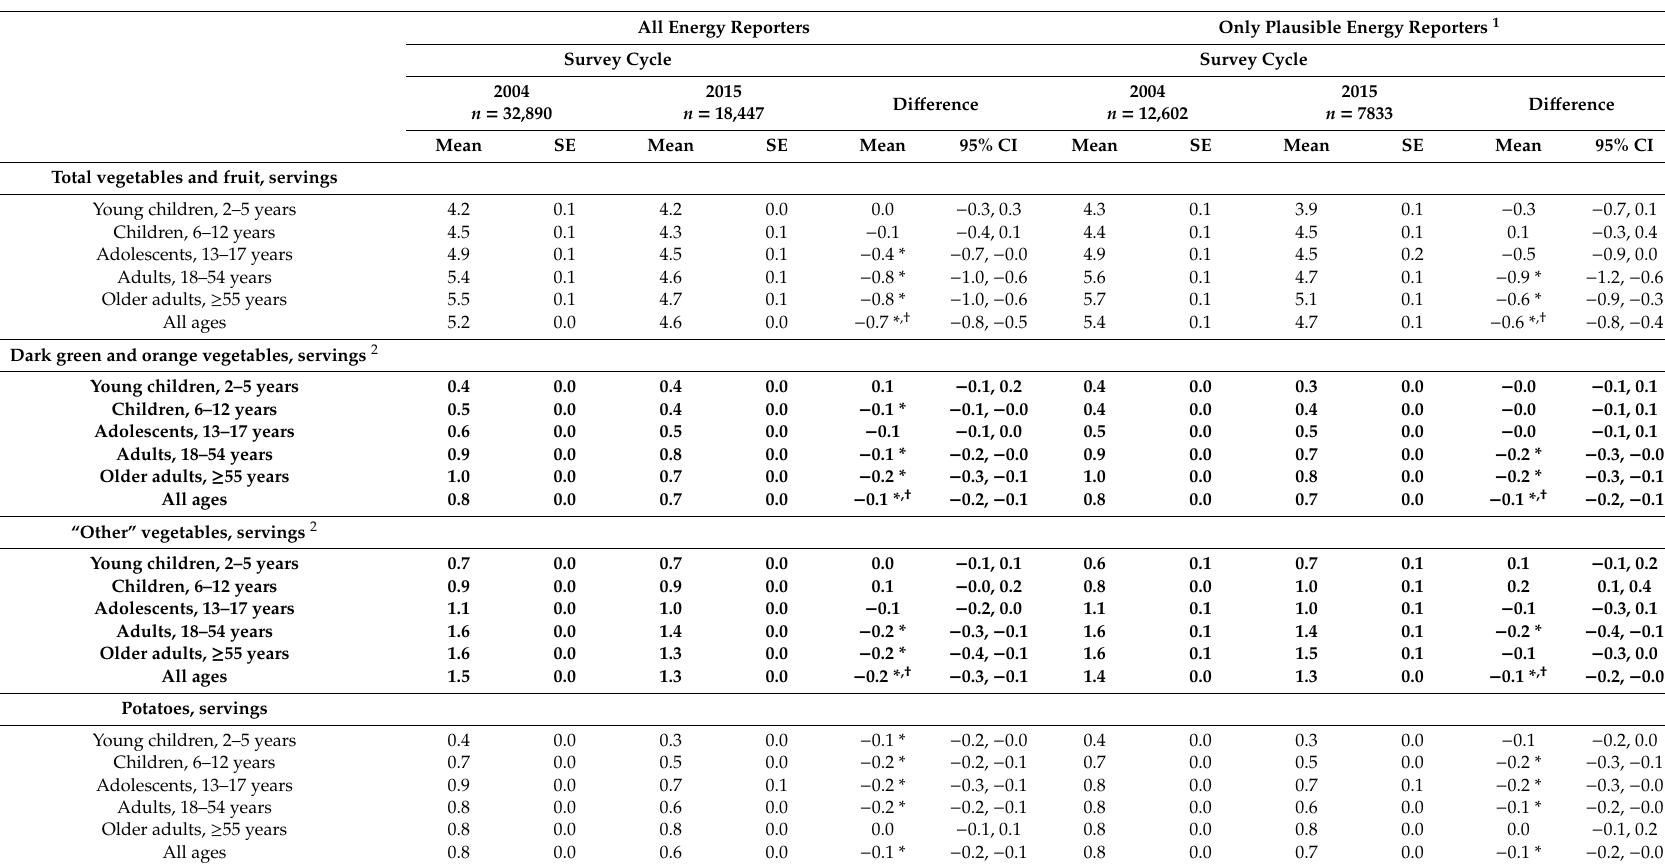
Table 1. Di ff erence in covariate-adjusted mean daily amounts of vegetable and fruit reported between 2004 and 2015 among Canadians ≥ 2 years old (all energy reporters and only plausible energy